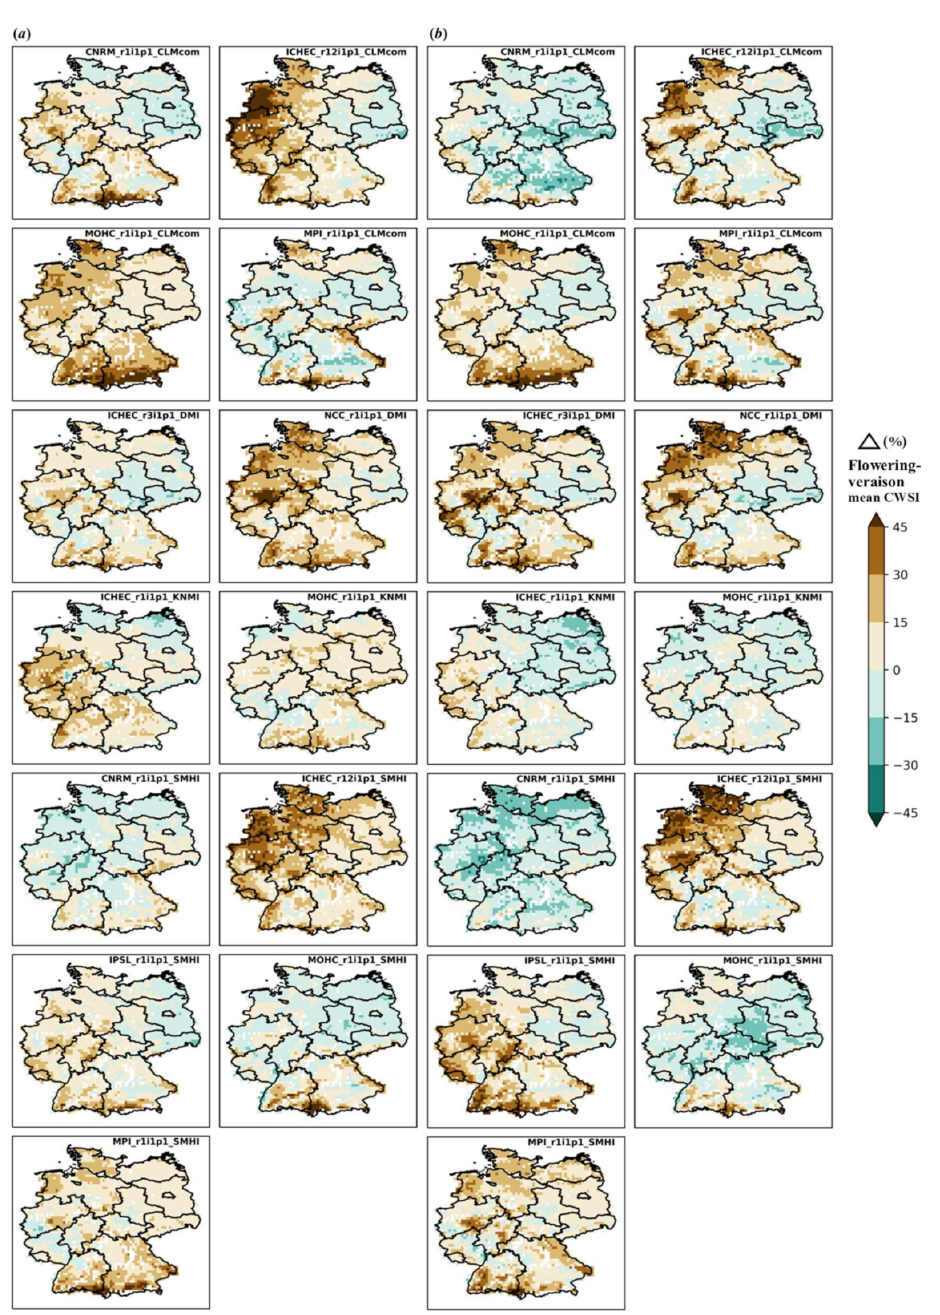
Figure A1. Individual model projections for changes (%) in mean crop water stress indicator (CWSI) during the flowering (BBCH65)-veraison (BBCH81) phenophase for the future period (2041–2070) under ( a ) RCP4.5 and ( b ) RCP8.5 as compared to the baseline period (1976–2005) for Müller-Thurgau. Positive values indicate increased CWSI (intensified water stress), whereas negative values denote respective reductions (alleviated water